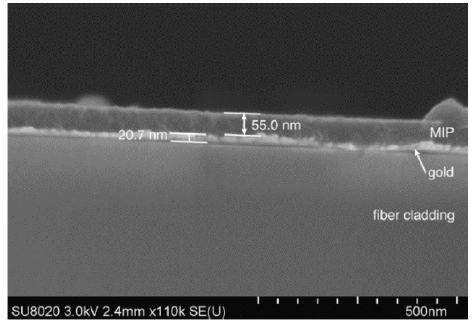
Figure 30. SEM image for a MIP coated onto an optical fibre by electropolymerization. Reprinted from [152] with permission from Elsevier.